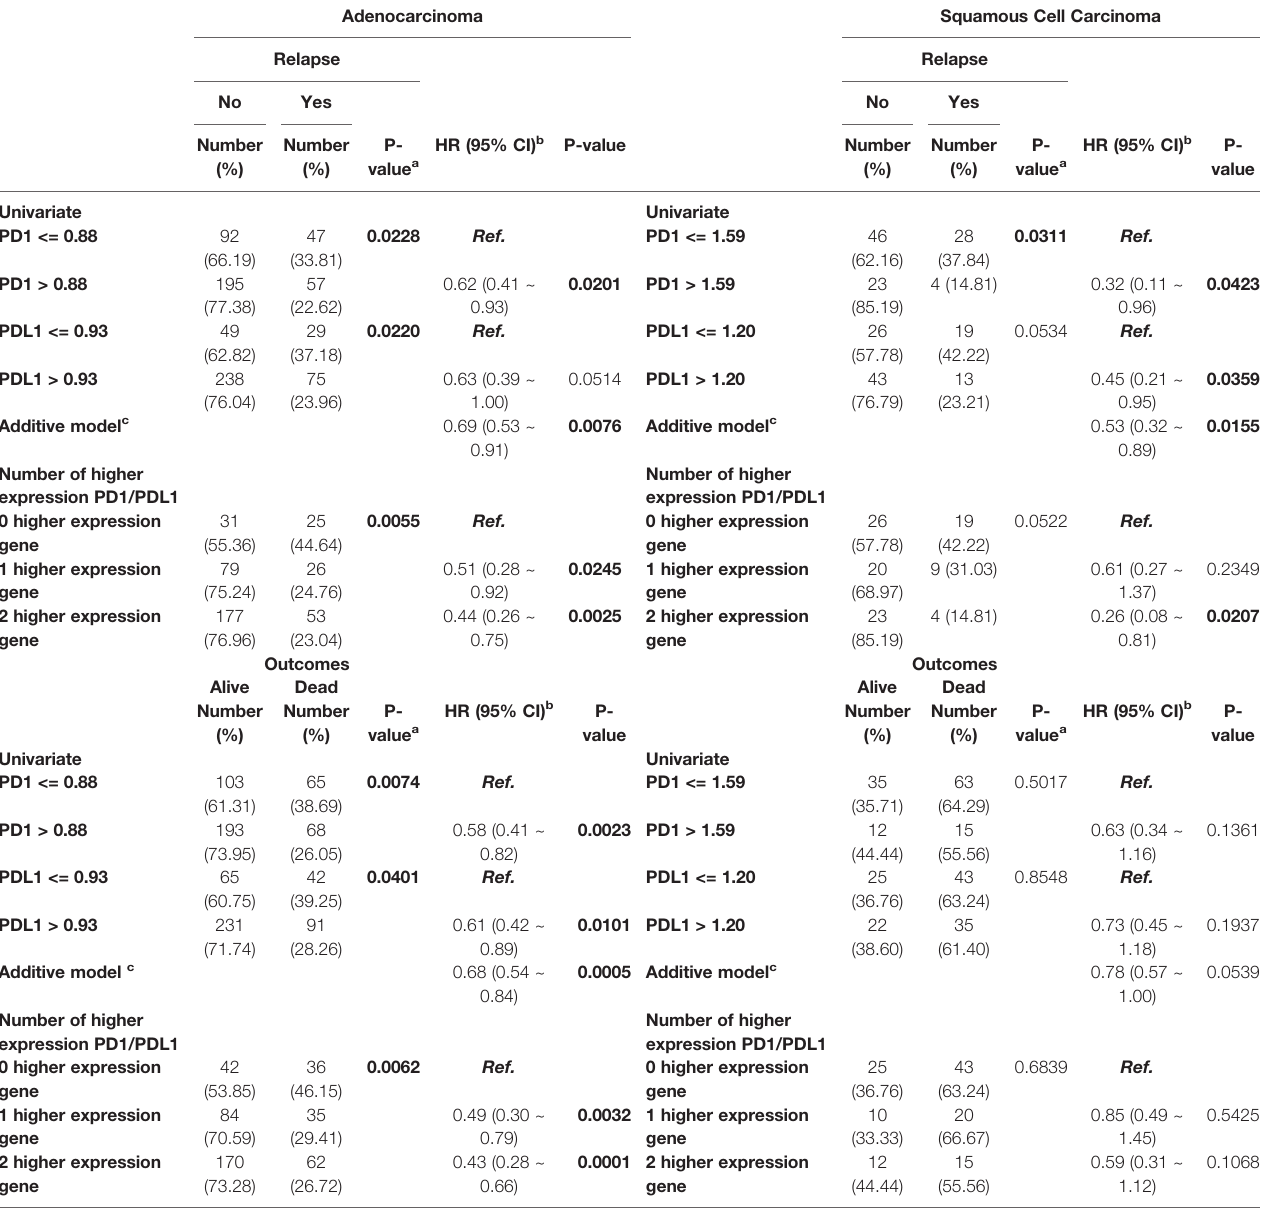
TABLE 2 | Cox regression analyses of PD1 and PDL1 gene expression levels at early stage lung cancer